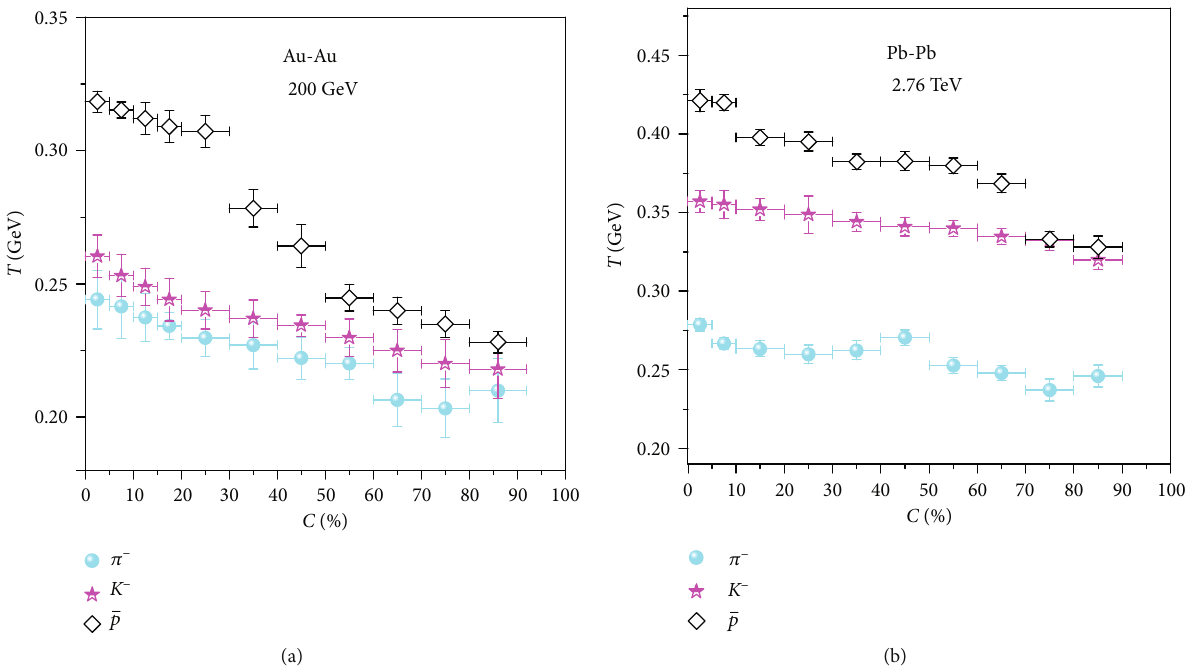
Figure 3: Dependence of e ff ective temperature T in di ff erent centrality bins C in (a) Au-Au collisions at 200GeV and (b) Pb-Pb collisions at 2.76TeV. The obtained values corresponded to the identi fi ed particles extracted from the experimental p T spectra.